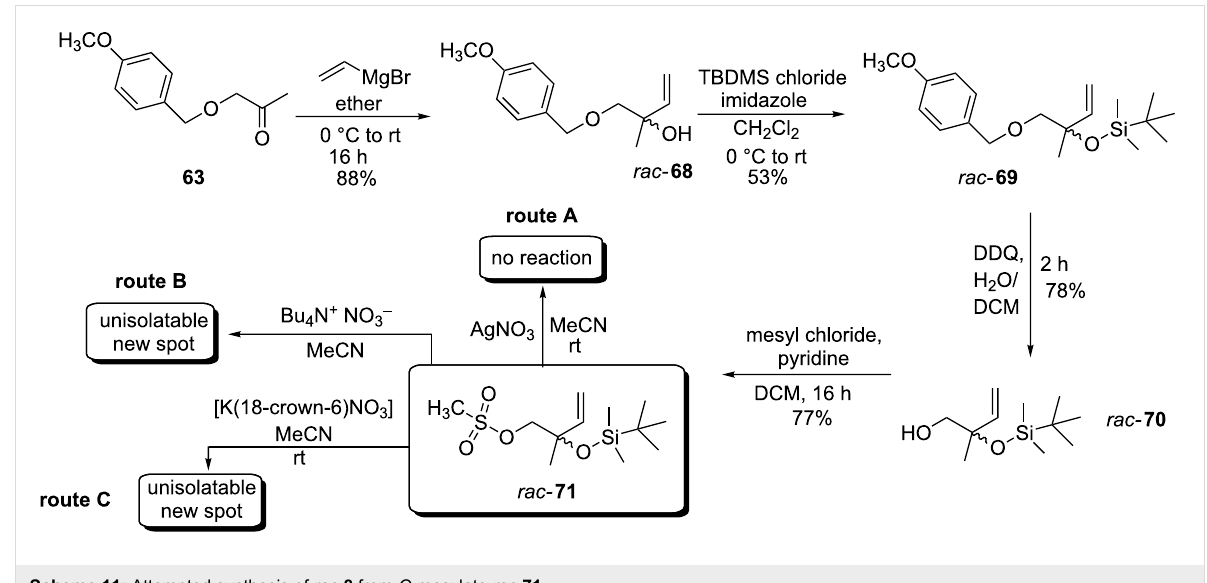
Scheme 11: Attempted synthesis of rac - 8 from O -mesylate rac- 71